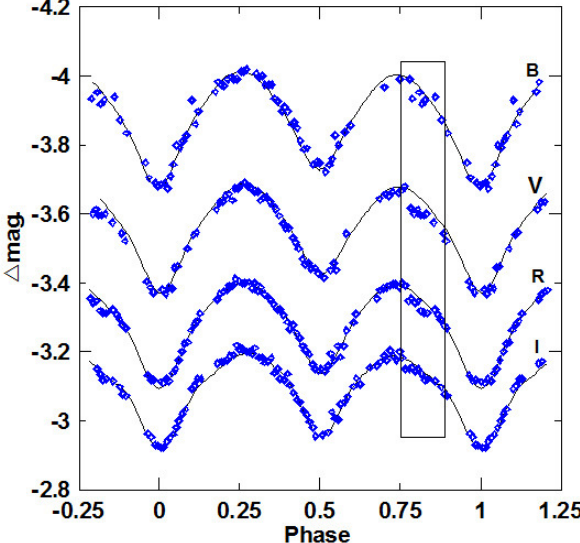
Fig. 3 The best match between the synthetic light curves and the observed light curves of binary IK Boo. The rectangle shows a hump like distortion in all the